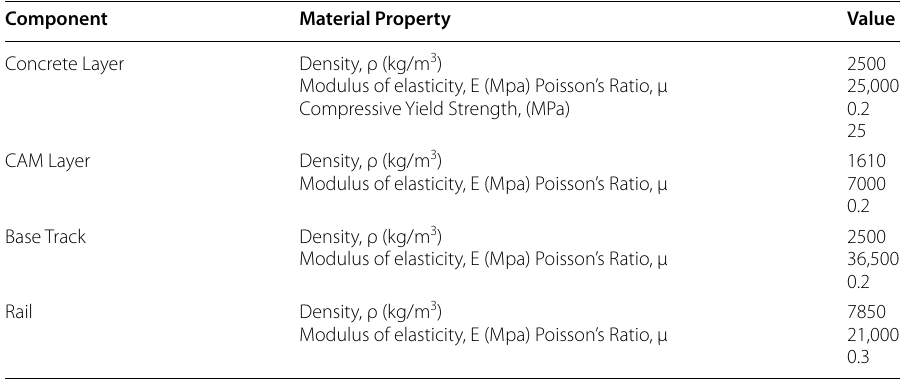
Table 6 Material Properties used in the 3D FEM model of the Track System Component Concrete